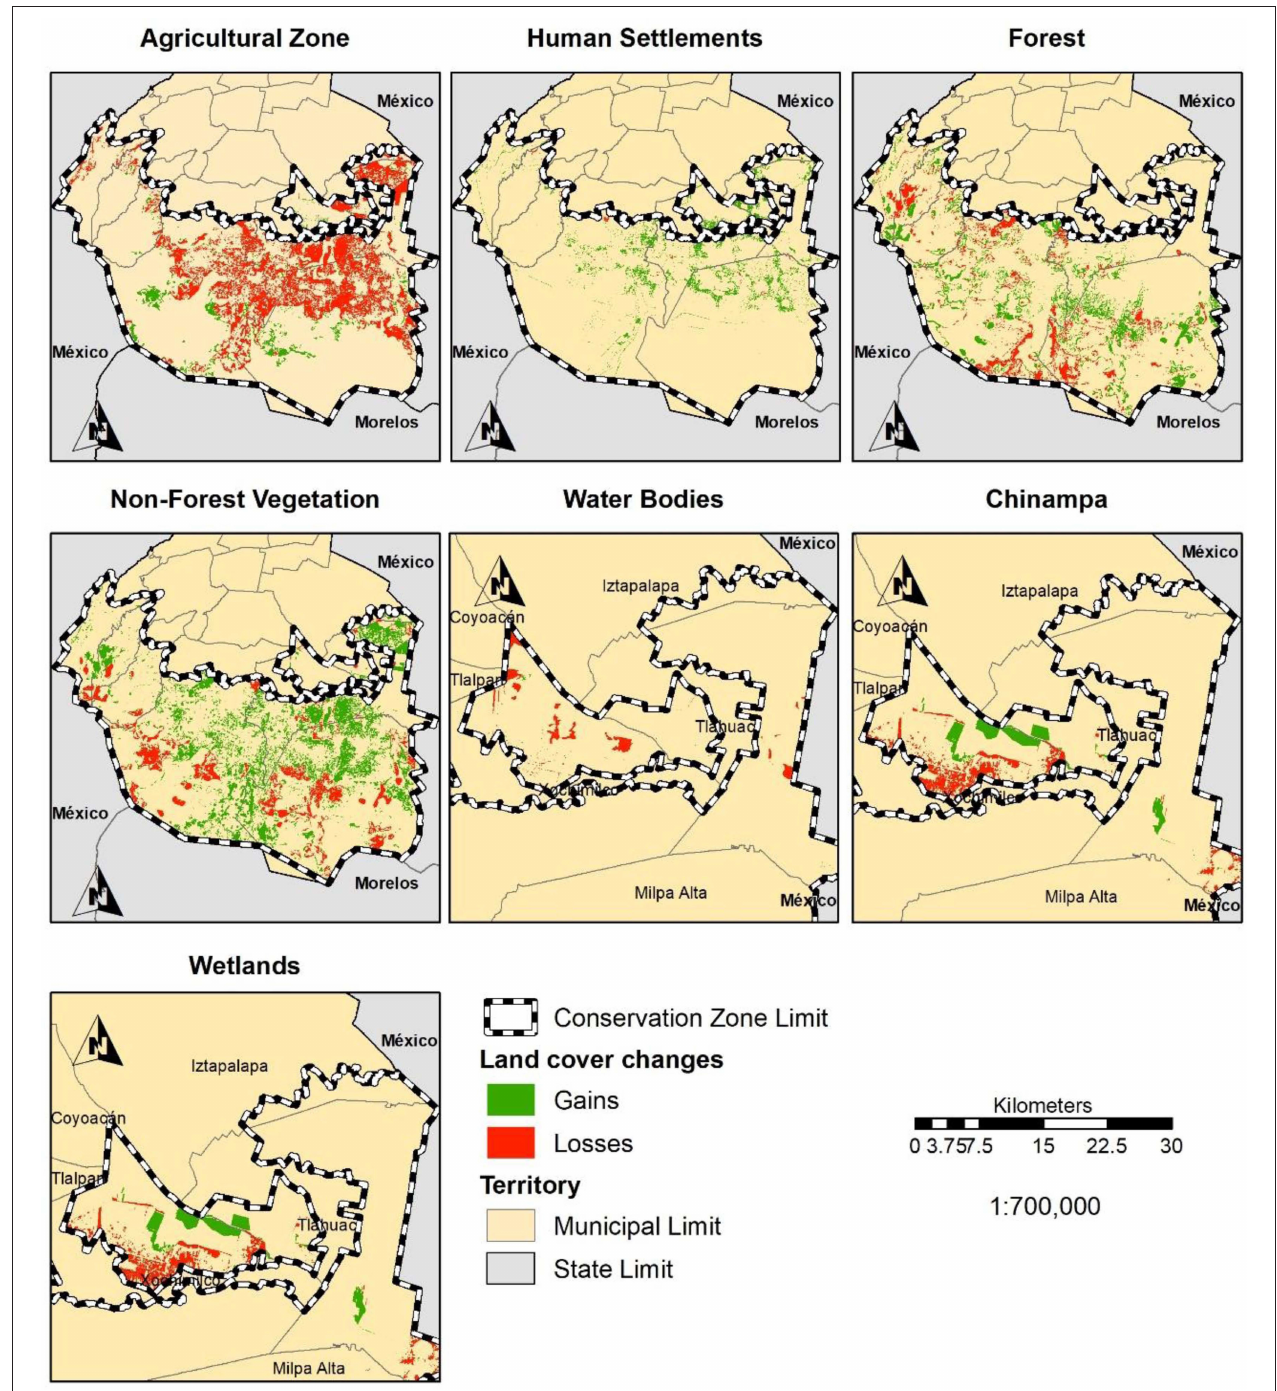
FIGURE 6 | The conservation zone: sequence of maps of land use gains and losses by category, 2000–2010. Elaborated from land use and vegetation layers of Serie II from INEG I (National Institute of Statistics and Geography, 2001); GDF (2012) Atlas Geografico del Sue lo de ConservaciÒn del Distrito Federal; and Esri Land Cover,